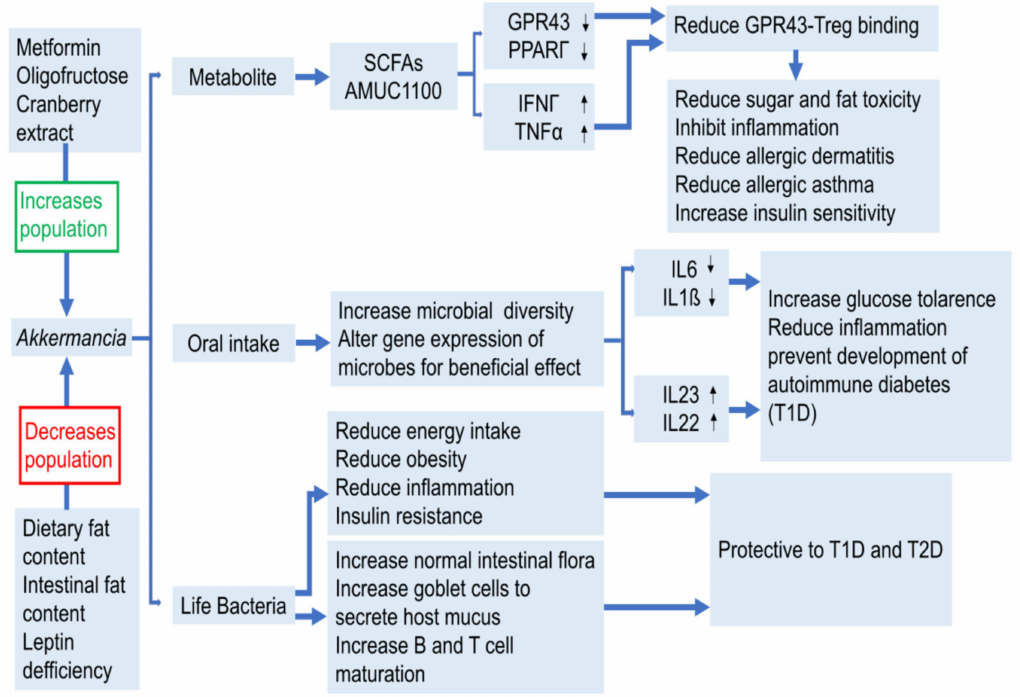
Figure 4. The role of A. muciniphila in regulating various diseases. Akkermansia appears to be a beneficial bacterium for human health and is associated with many disease symptoms. Its population increases through dietary constituents such as cranberry extract or drug metformin whereas decreases as a result of a high fat diet or intestinal fat content. Akkermansia metabolites increases SCFAs that in turn regulate GPR43 or IFN γ to inhibit Treg, which reduces inflammation, symptoms of asthma and allergy. They also help to enhance metformin effect to increase insulin sensitivity. It also plays a role to reduce inflammation and development of T1D. FMT of Akkermansia has been proved to prevent or delay the onset of T1D and T2D. Akkermansia transplantation could be developed as a potential therapeutic agent for diabetes, allergy and